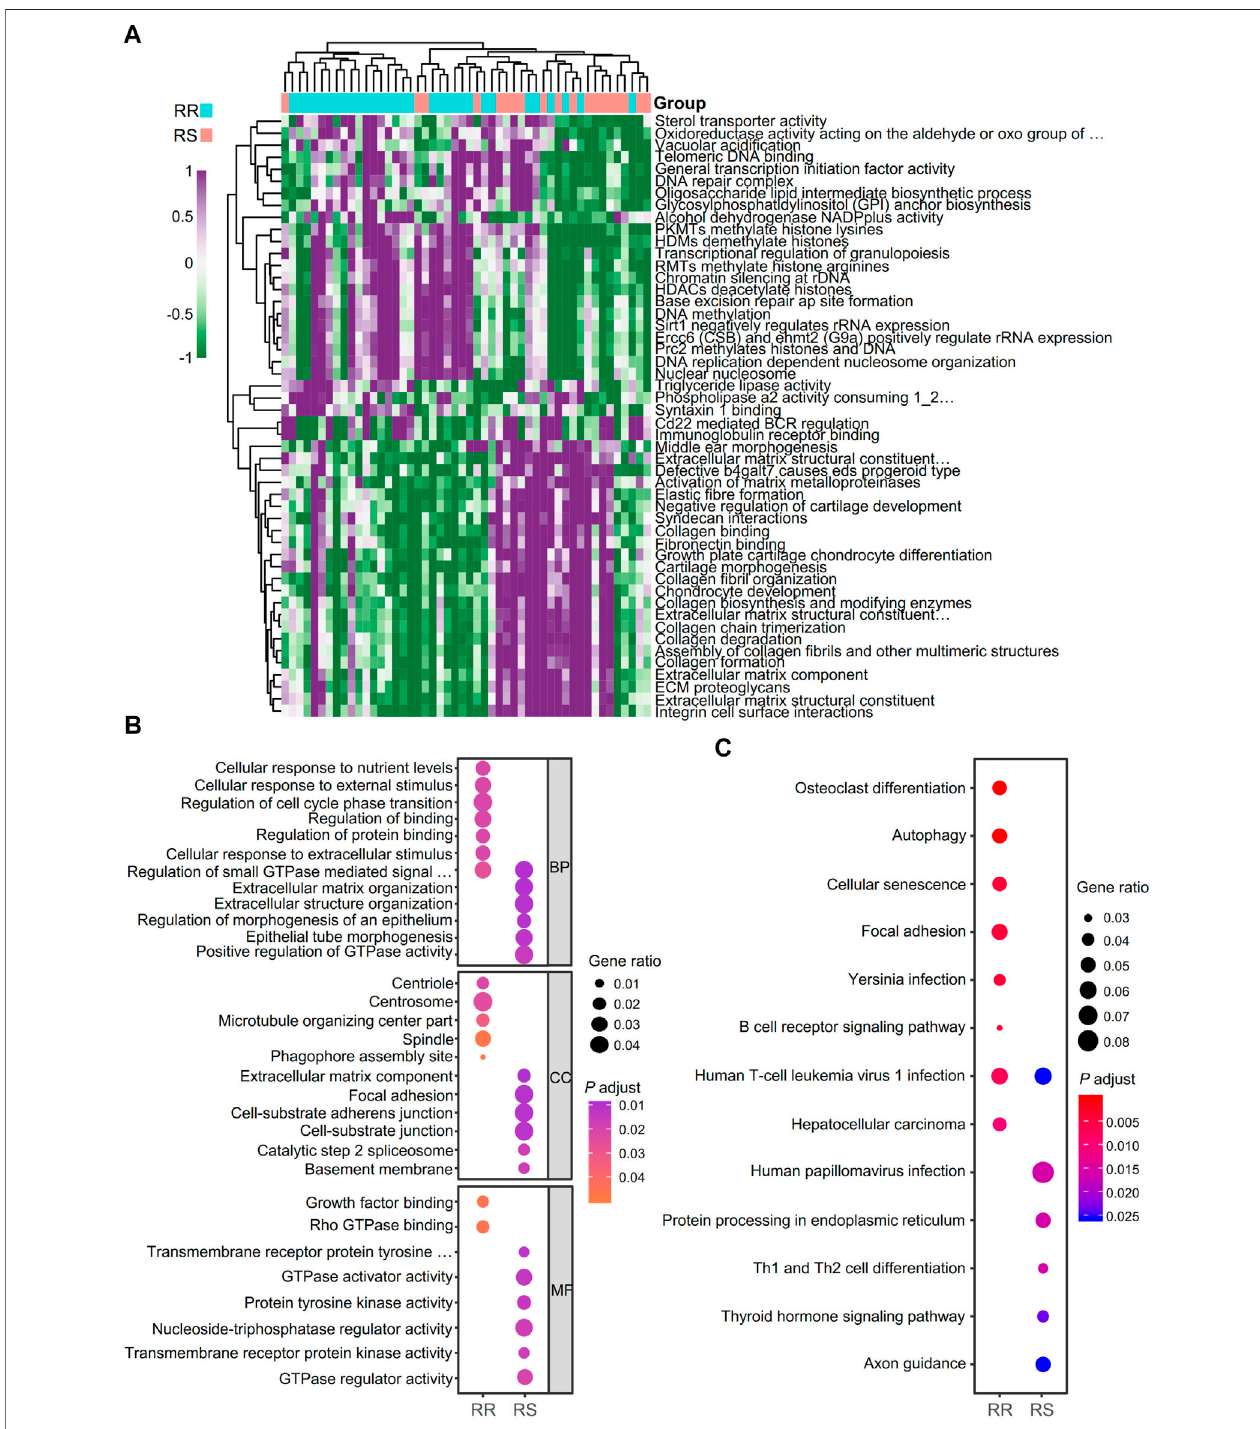
FIGURE 2 | Identi fi cation of biological function and neoantigen-coding genes of RT patients. (A) Analysis of the biological functions of RT patients with GSVA. RR, radioresistant;RS,radiosensitive. (B) GOtermanalysisfordifferentialneoantigen-codinggenesbetweentheRRandRSgroupsintheTCIAdatabase. (C) KEGGanalysis of differential neoantigen-coding genes between the RR and RS groups in the TCIA database.